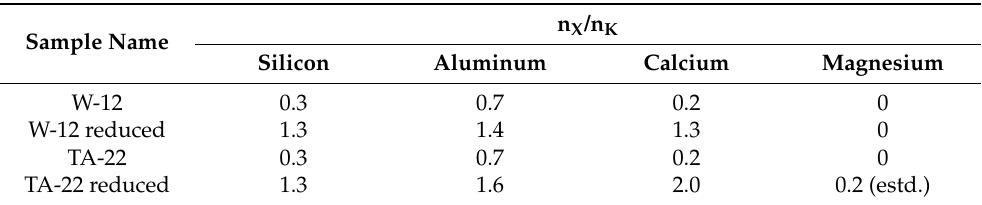
Table 4. The atomic concentrations of promoters related to the atomic concentration of potassium as observed by